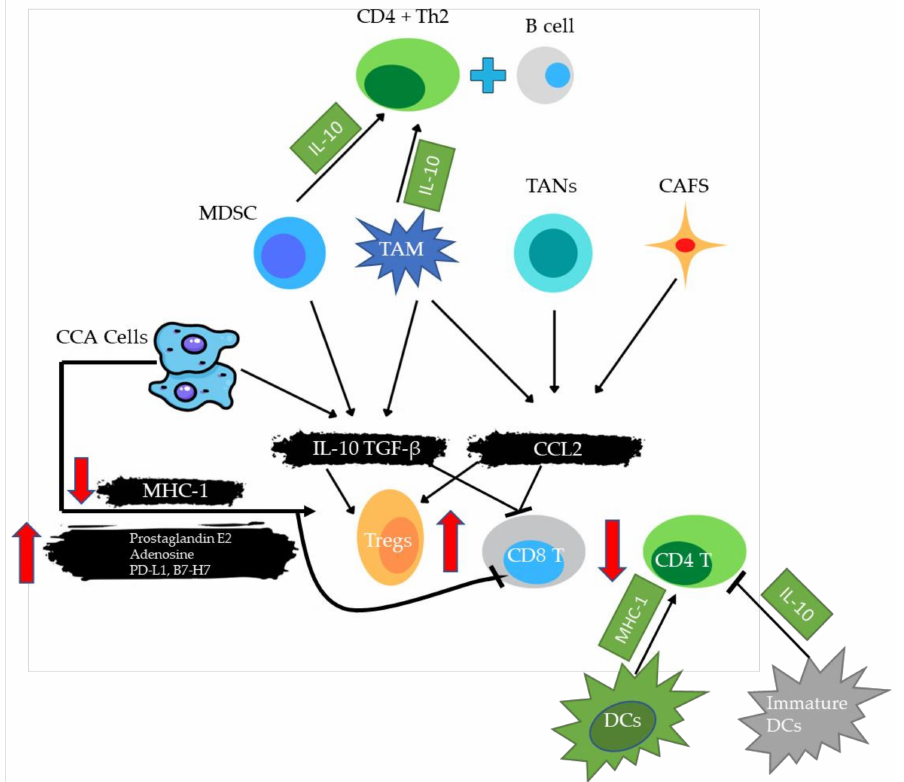
Figure 6. An illustration depicting the interaction between TILs and immune/cancer cells in the tumor microenvironment. Cancer cells, TAMs, and MDSCs release IL-10 and TGF-, while TAMs, TANs, and CAFs release CCL2, which recruits and boosts Tregs, while limiting CD8+ T-cell activity inside the tumor bed. Cancer cells can also directly affect the immune response through overproducing prostaglandin E2, adenosine, PD-L1, or B7-H7, or through lowering MHC-I surface expression. MSDCs and TAMs release IL10, which induces a CD4+ Th2 response with B-cell activation, both of which are effective cancer immunosurveillance mechanisms. Mature DCs stimulate CD4+ T-cell activity by increasing MHC 1 expression, whereas immature DCs decrease CD4+ T-cell activity through secreting IL-10. B7-H7, B7 homolog 7; CAFs, cancer-associated fibroblasts; CCL, C–C motif chemokine ligand; CD, cluster of differentiation; DCs, dendritic cells; IL, interleukin; MDSCs, myeloid-derived suppressor cells; MHC, major histocompatibility complex; PD-L1, programmed death-ligand 1; TANs, tumor-associated neutrophils; TAMs, tumor-associated macrophages; TGF, transforming growth factor; Tregs, regulatory T cells (modified from